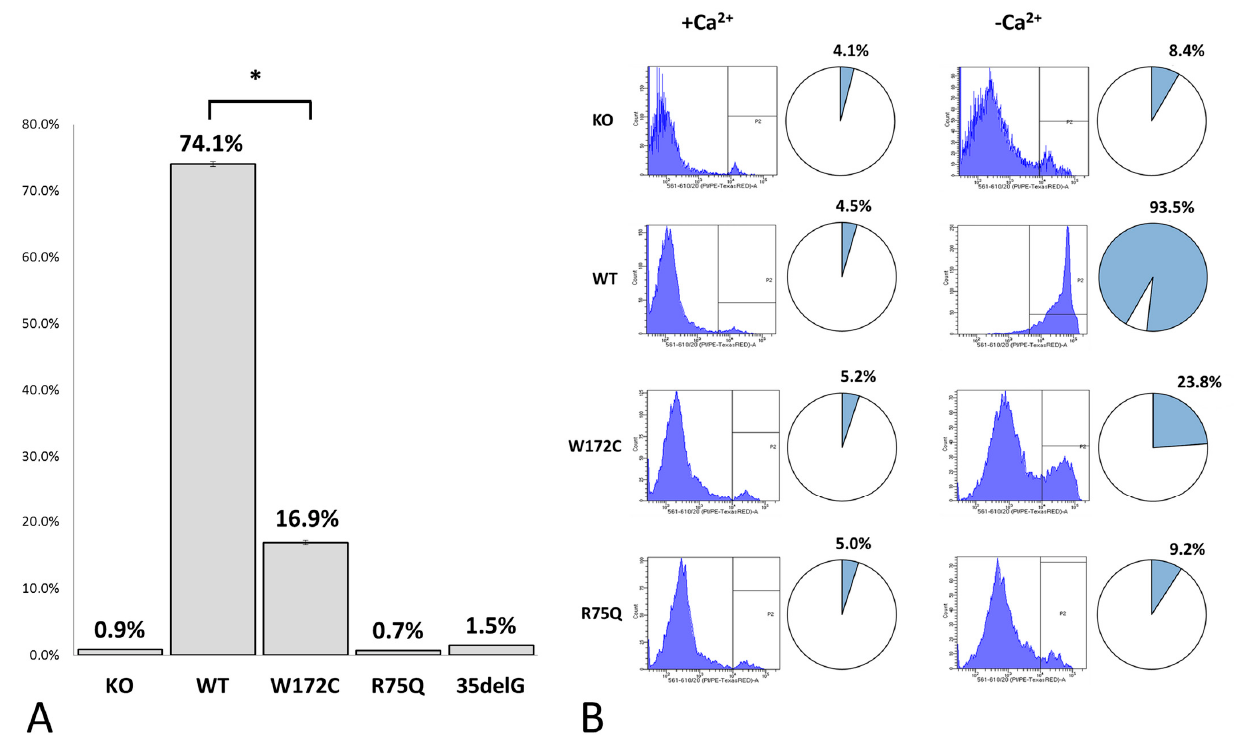
Figure 4. Percentage of cells loaded with propidium iodide (PI) through hemichannels. ( A ) Proportion of PI-positive cells estimated by analysis of fluorescent microscopy images (the data were obtained for cells in Ca 2+ -free HBSS). Bars represent the mean ( ± SEM) for each of analyzed cell lines. * denotes significant differences at p < 0.05. ( B ) Percentage of cells loaded with PI estimated by flow cytometry in Ca 2+ -containing (left) and Ca 2+ -free (right) extracellular conditions. KO, WT, W172C, R75Q, and 35delG denote lines HeLa Cx26-KO, HeLa-Cx26wt, HeLa-p.W172C, HeLa-p.R75Q, and HeLa-c.35delG, respectively.